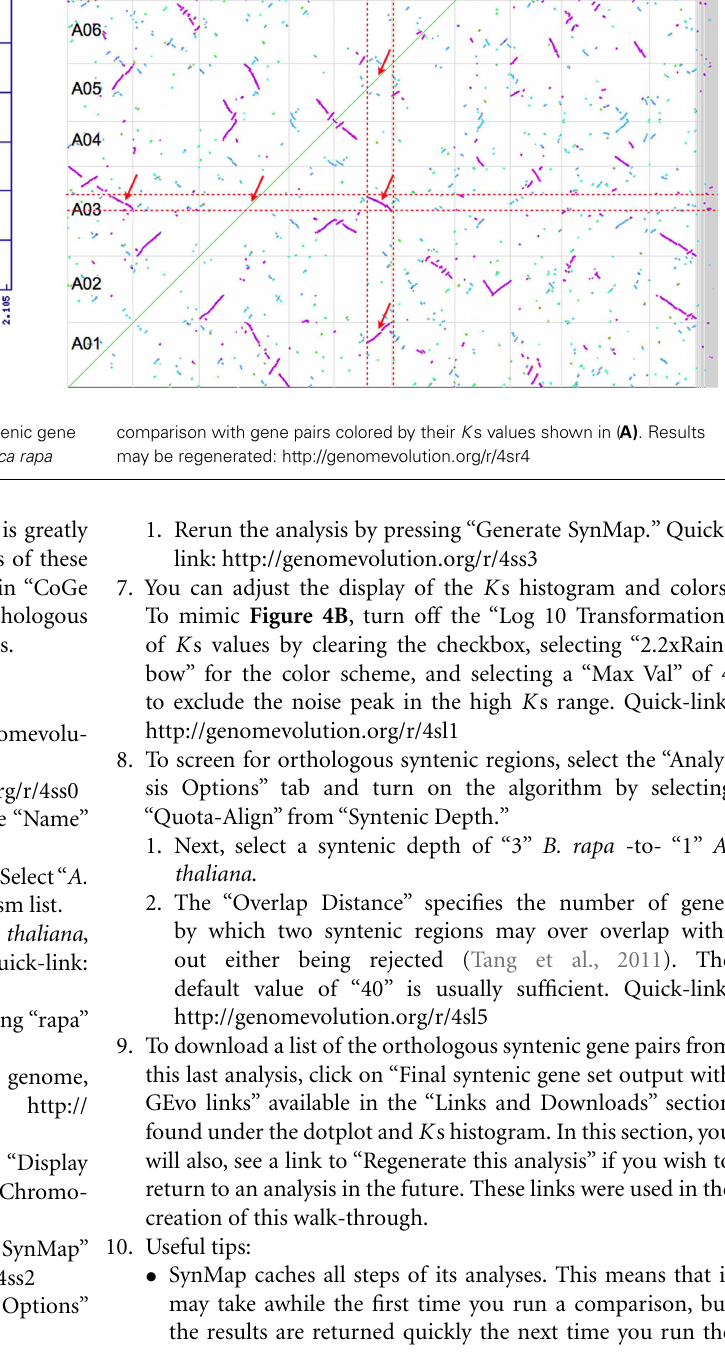
FIGURE 3 | (A) Histogram of log 10 transformed K s values of syntenic gene pairs identified in Figure 2 . (B) Syntenic dotplot of self–self Brassica rapa